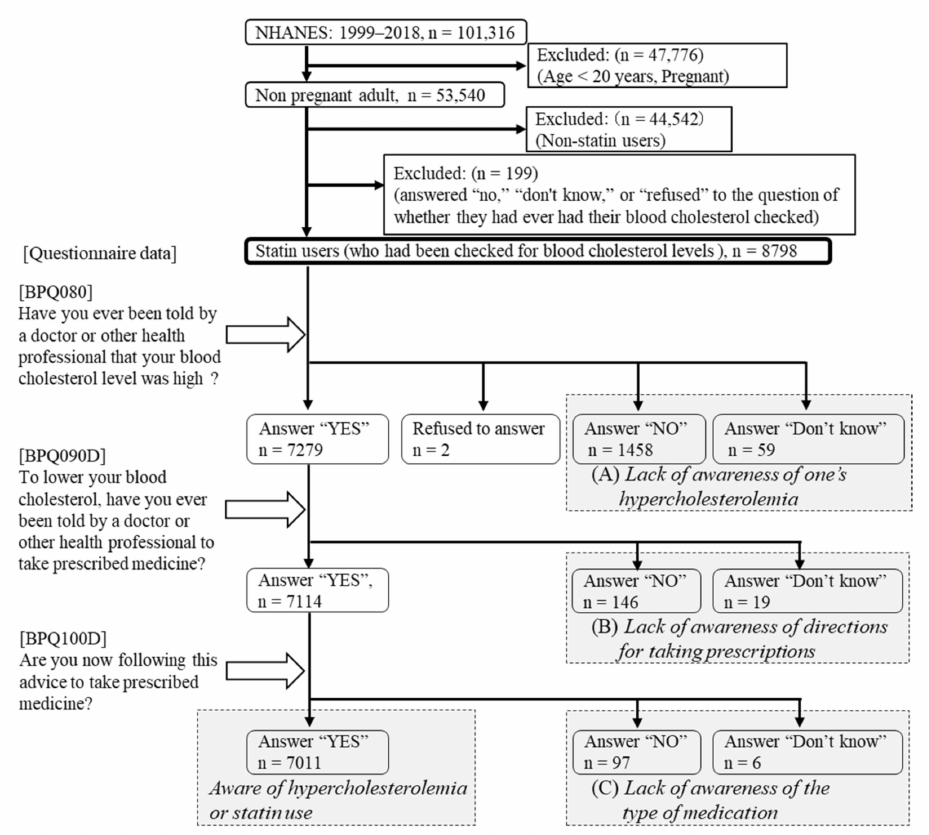
Figure 1. Study flow diagram. Abbreviation: NHANES, National Health and Nutrition Examination Survey. Statin users were classified in accordance with their responses. Lack of awareness of one’s own hypercholesterolemia or statin use was regarded as the sum of ( A ) lack of awareness of one’s hypercholesterolemia; ( B ) lack of awareness of directions for taking their prescription; and ( C ) lack of awareness of the type of